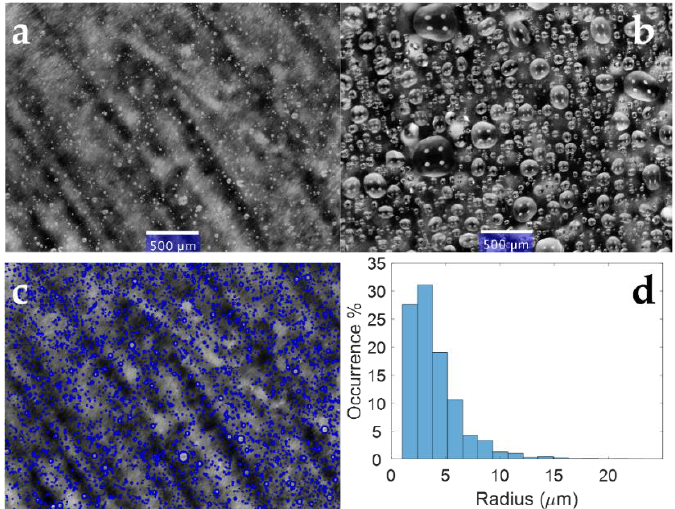
Figure 4. Microscopic images of droplets generated by ( a ) EHDA-MQL and ( b ) MQL, ( c ) image processing and ( d ) probability histogram of the droplet radius generated by EHDA-MQL.